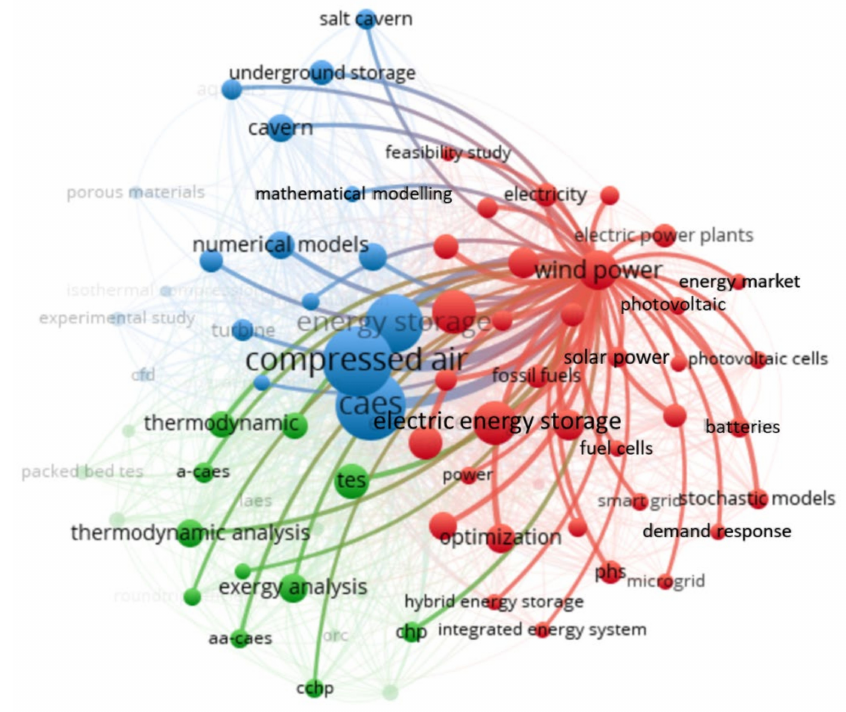
Figure 11. Network of the keyword “wind